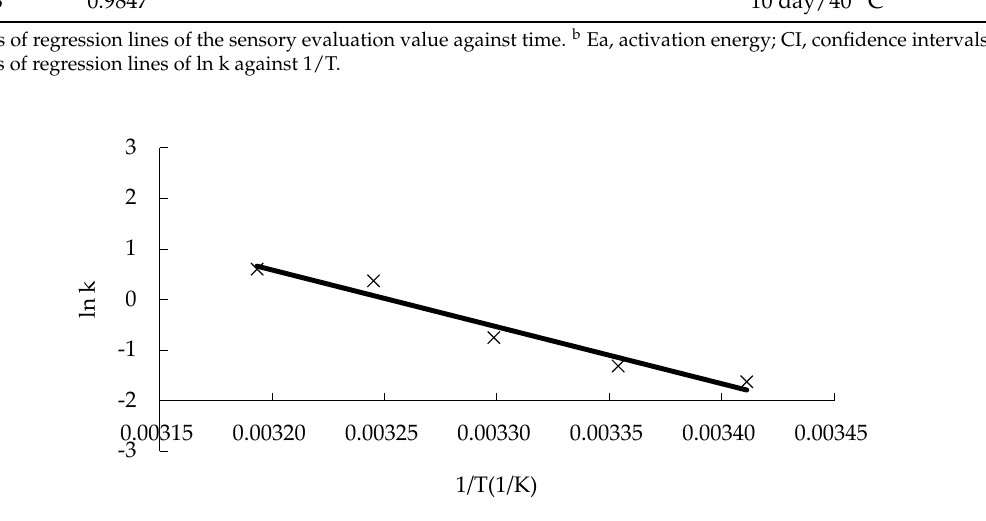
Figure 5. Arrhenius behaviour curve of “boba” ball quality.